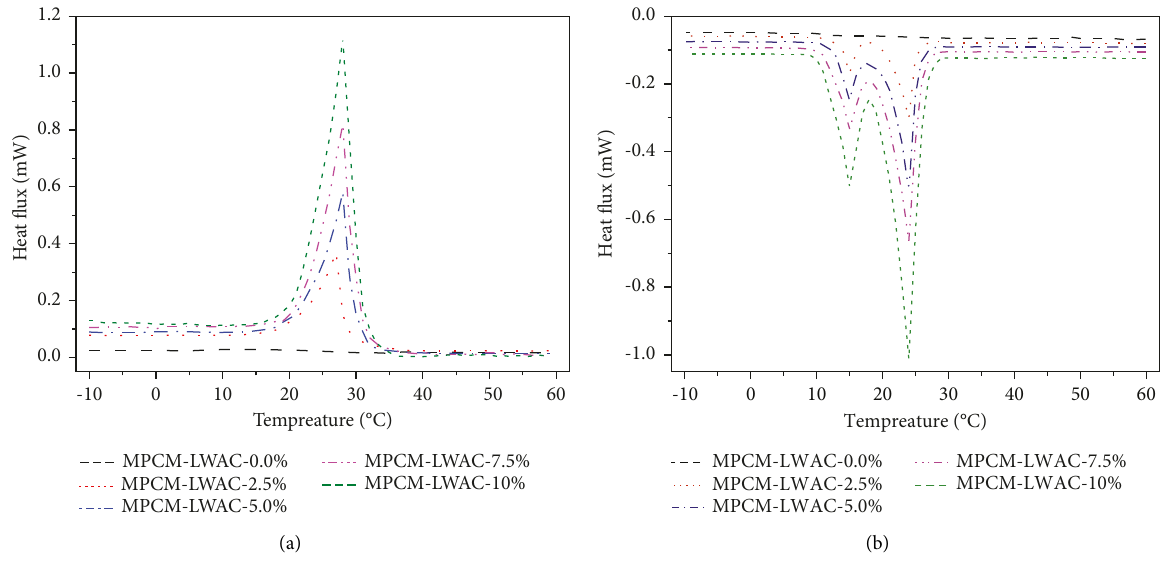
Figure 9: DSC curves of MPCM-LWAC with different MPCM contents. (a) Heat absorption by melting. (b) Heat release by solidification.